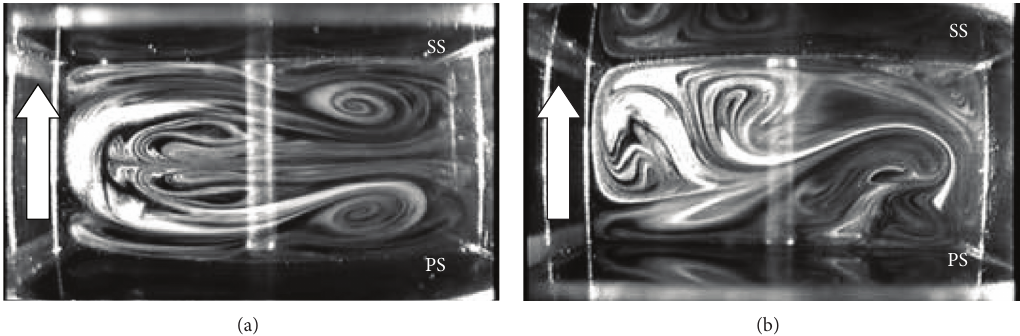
Figure 23: Flow visualization images from Elfert et al. [50] for the 180 ∘ bend region of the two-pass channel, viewing the flow in the negative z -direction with the bend entrance on the left and the bend exit on the right. (a) Image without rotation. (b) Image with rotation.